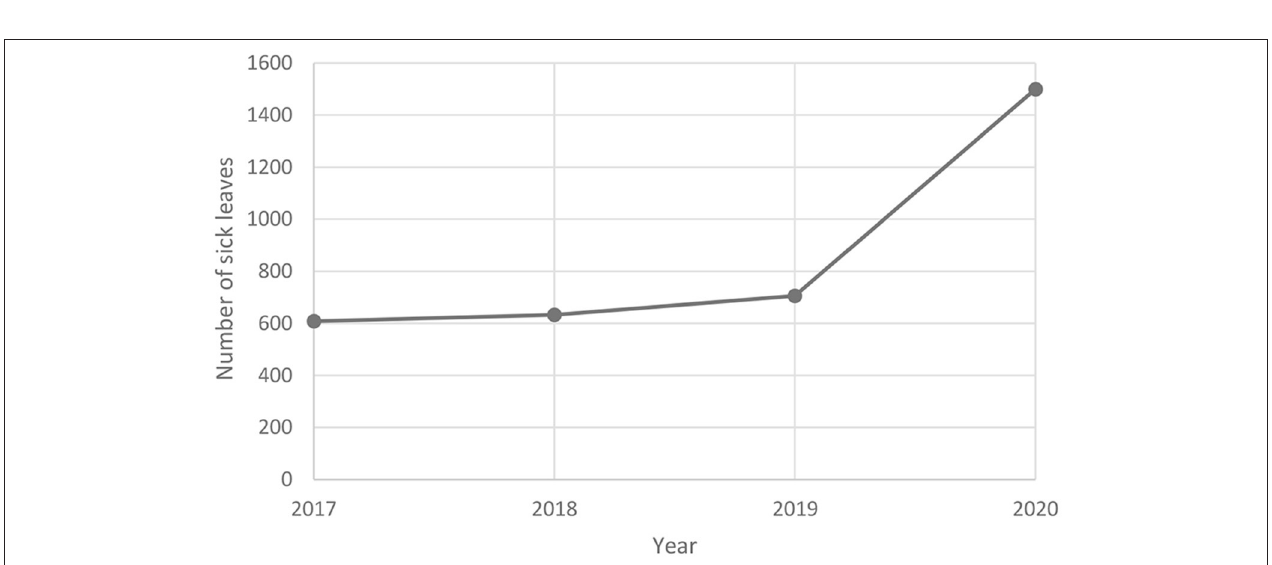
FIGURE 2 | Number of sick leaves due to mental disorders in Poland in 2017–2020. Own study based on: https://www.zus.pl/baza-wiedzy/statystyka/opracowania- tematyczne/absencja-chorobowa.